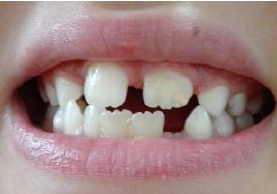
Figure 9: follow up after 3 years clinical view showing eruption of both central incisors (note; the age of the child at this time was 7 years and 1